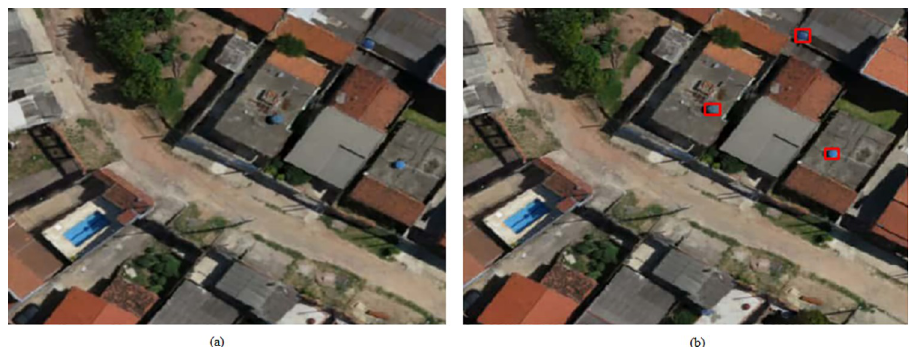
Fig 6. Water tank detection in Area 4. A sample of the UAV image without water tank detection is shown in (a) while (b) shows the water tank detection through bounding boxes. Satellite images published under a CC BY license, with permission from G drones, original copyright 2016.